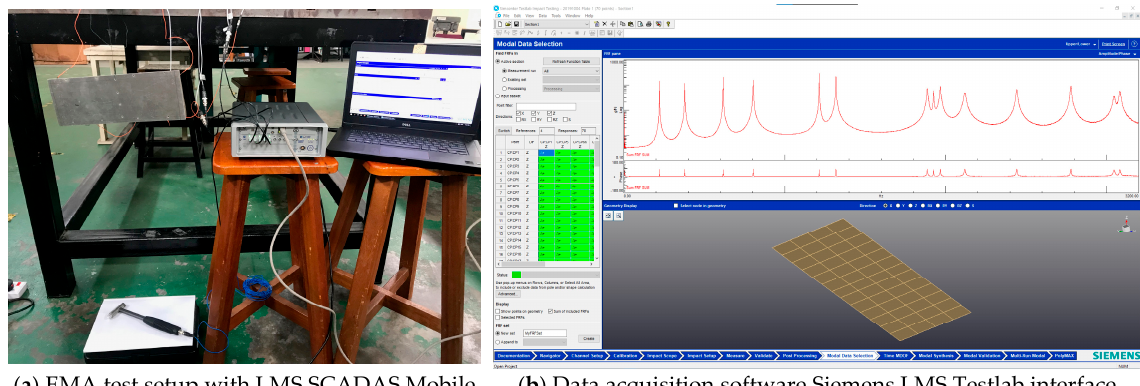
Figure 9. Experimental modal analysis testing setup and software interface. A total of 70 hammer strike points were defined upon each of the five plates, distrib- uted such that these strike points were located away from the outer edges of the plates. This number of strike points was seen to be required to characterize the acquired mode shapes in a better manner than if lower numbers were implemented, in terms of the aver- aging process integral to the EMA data acquisition process; furthermore, it was required to acquire sufficiently detailed modal information to ensure that no local modes devel- oped in the plates, within the frequency range the current work was interested in, would be undetected. The same strike point map was implemented on all five plates; the points were designed to fall at the nodes joining the corners of the perforation unit areas. Figure 10 shows the hammer strike points for the EMA measurement points.